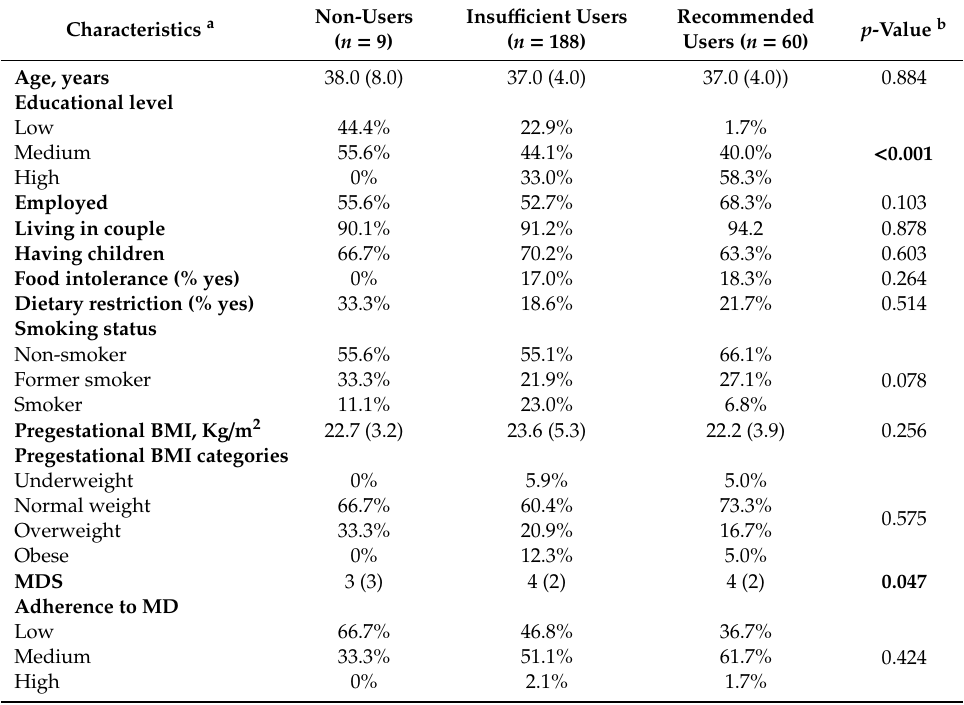
Table 2. Characteristics of folate deficient women according to supplement use.